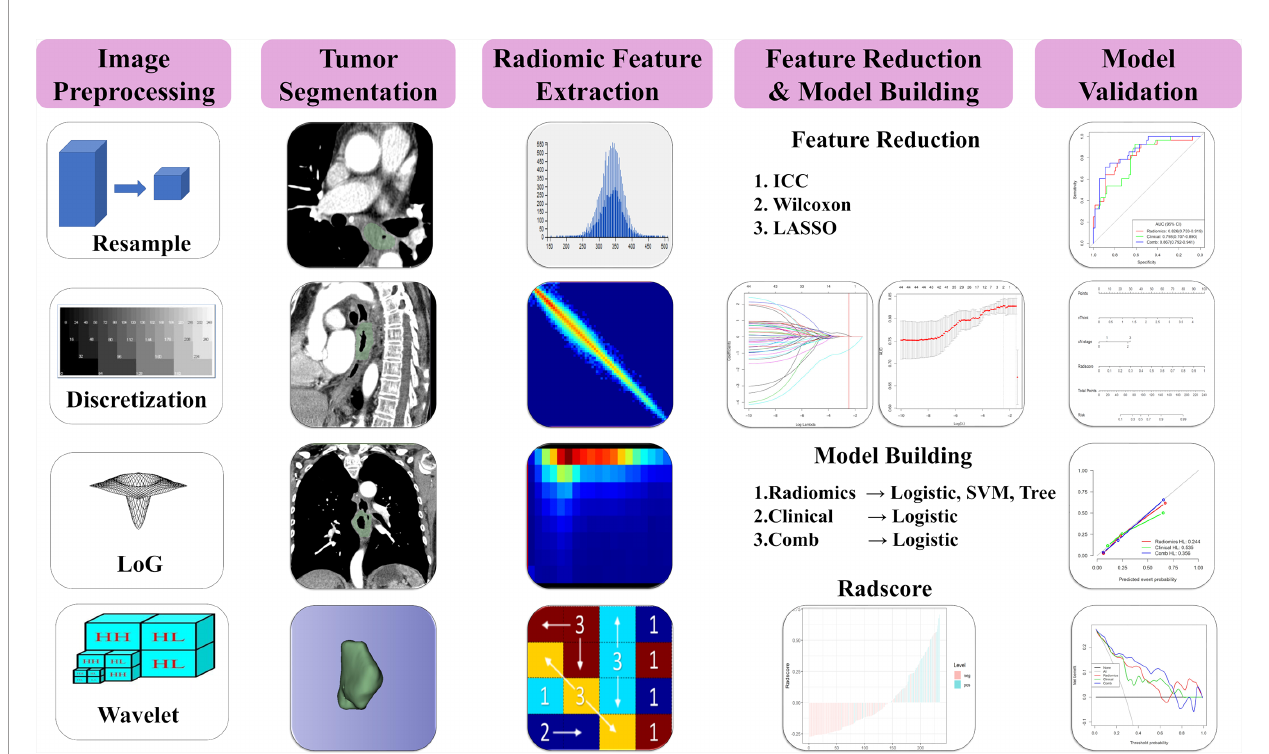
FIGURE 2 | Radiomics prediction pipeline for